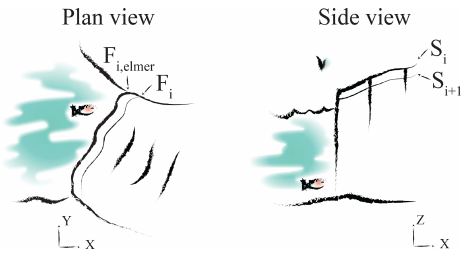
Figure 1. Conceptual plan and side view of an Elmer/Ice transient run. The initial front F i and surface S i are evolved to a new front position F i, elmer and a new surface elevation S i + 1